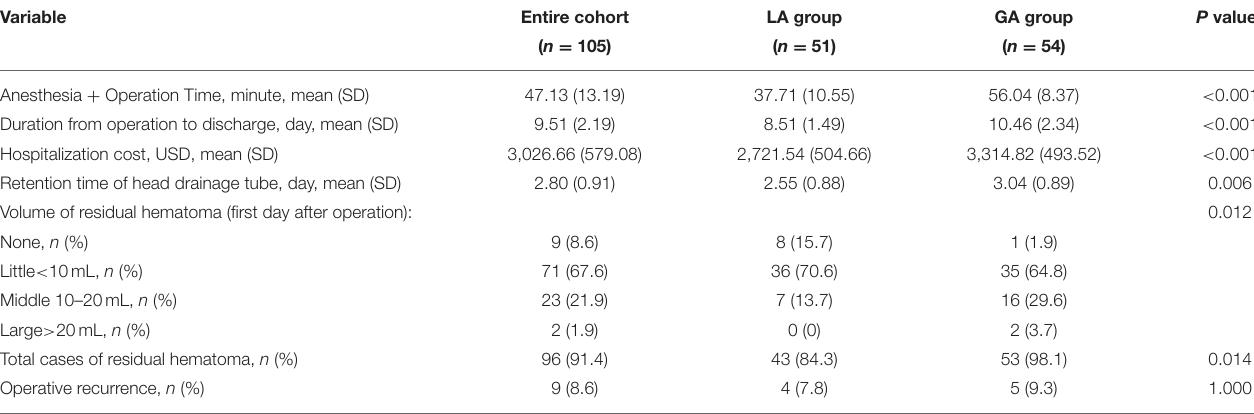
TABLE 3 | Postoperative information.